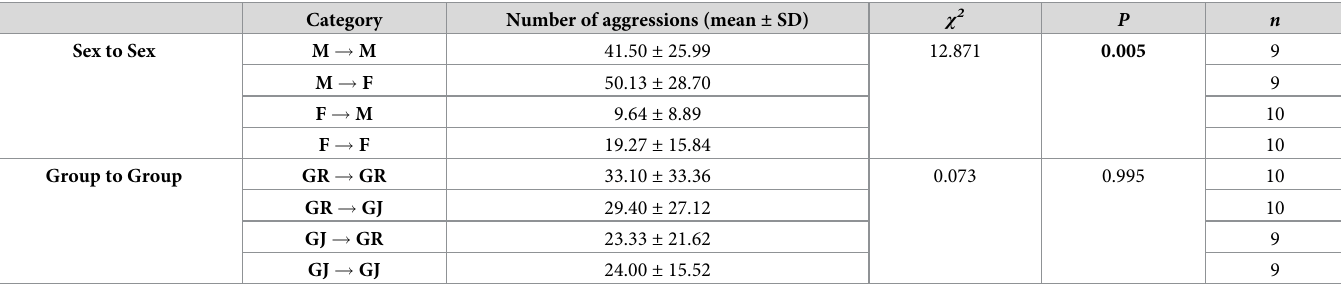
Table 1. Number of aggressive behaviours, categorized by sex-to-sex dyads and group-to-group dyads (referring to capture-site